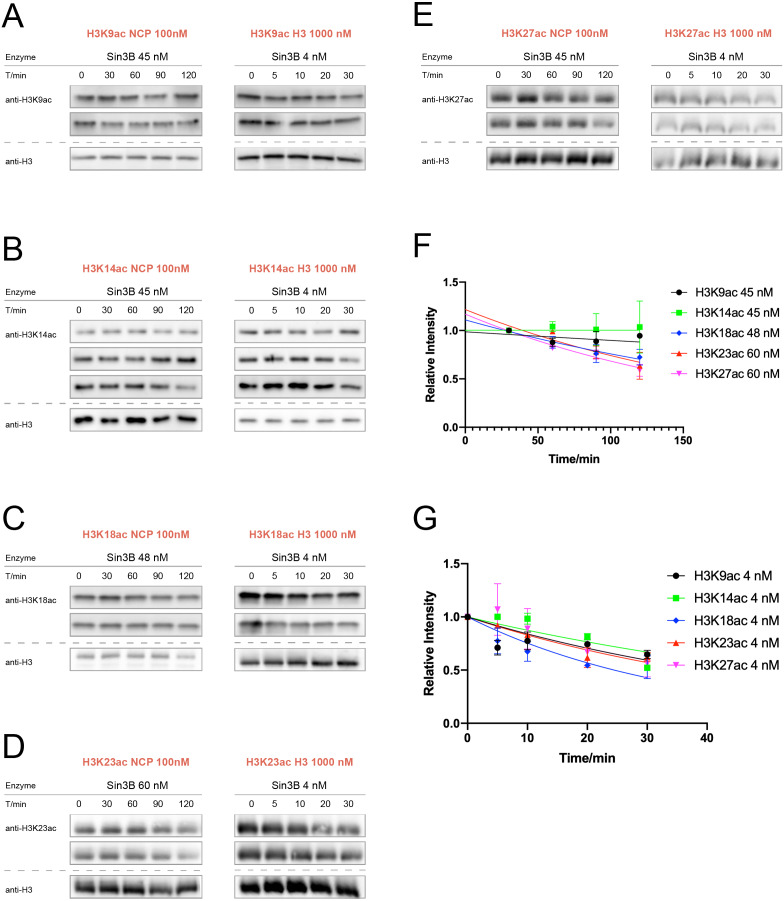
Sin3B (Sin3-HDAC1-RBBP4) activity assay over nucleosomes or histones with acetylation at different sites.(A) H3K9ac (n = 2 for nucleosome assay; n = 2 for histone assay), (B) H3K14ac (n = 3 for nucleosome assay; n = 3 for histone assay), (C) H3K18ac (n = 2 for nucleosome assay; n = 2 for histone assay), (D) H3K23ac (n = 2 for nucleosome assay; n = 2 for histone assay), (E) H3K27ac (n = 2 for nucleosome assay; n = 2 for histone assay). (F) Curve fitting for nucleosome kinetics with 45, 48 or 60 nM Sin3B labeled in the graph, and (G) Curve fitting for histone kinetics with 4 nM Sin3B labeled in the graph.